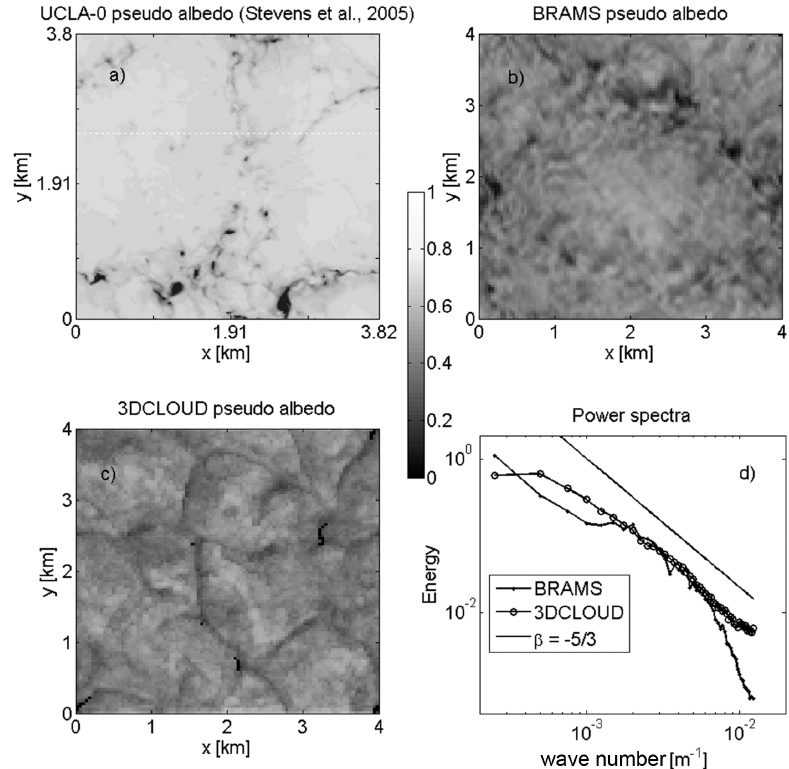
Figure 7. The instantaneous cloud-field snapshots of the pseudo albedo at 4 hours simulated by (a) the UCLA-0 model (picture taken from Stevens et al., 2005), (b) the BRAMS model, both configured following the DYCOMS2-RF01 case (Stevens et al., 2005) and (c) from 3DCLOUD with assimilation of meteorological profiles based on the DYCOMS-RF01 case. The UCLA-0 field is drawn from simulation where N x = N y = 192 and 1 x = 1 y = 20m. Both BRAMS and 3DCLOUD are drawn from simulations where N x = N y = N z = 100, 1 x = 1 y = 40m and 1 z = 12m. Note that the 3DCLOUD field is obtained at the second step of the algorithm, with the inhomogeneity parameter ρ τ = 0 . 3, mean optical depth ¯ τ = 10 and L out = 2km. (d) is the optical depth power spectra computed following the x and the y directions and then averaged, for BRAMS (points) and 3DCLOUD (circles). A theoretical power spectrum with spectral slope β = − 5 / 3 is added (black